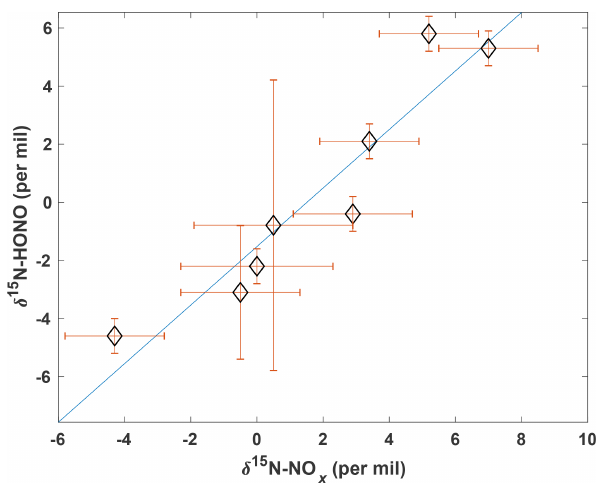
Figure 6. Scatter plot between δ 15 N–HONO and δ 15 N–NO x . All error bars are the propagation of replicate uncertainty ( ± 1 σ ) and method uncertainty. Linear regression follows δ 15 N − HONO = 1 . 01 δ 15 N − NO x − 1 . 52 (R 2 = 0 . 89, p < 0 .